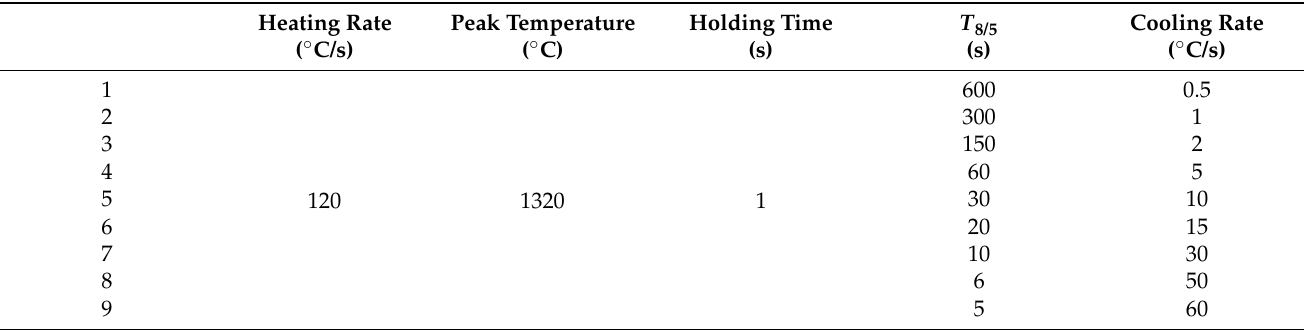
Table 3. Thermal simulation